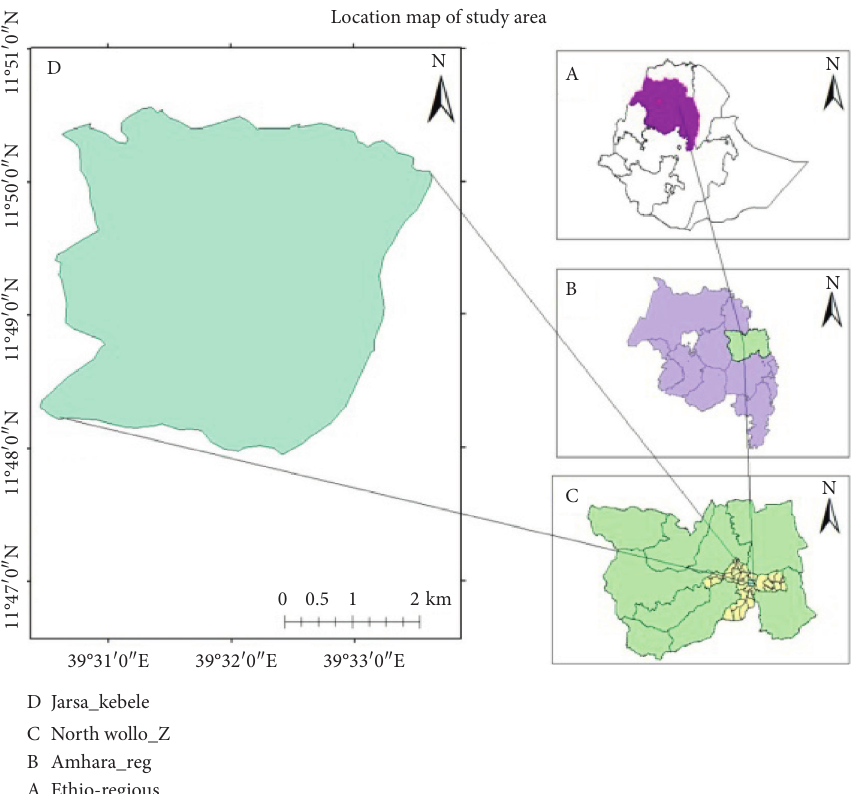
Figure 1: Geographical map showing the location of the study